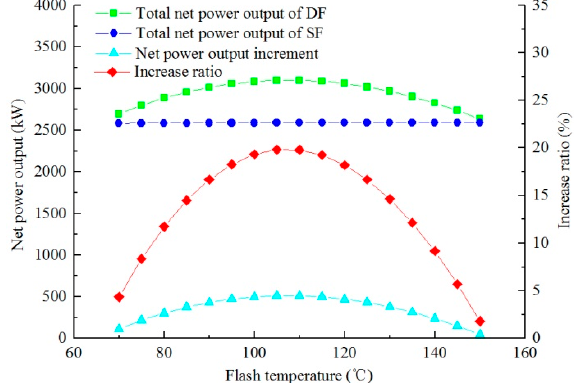
Figure 5. Variations of net power output of DF with flash temperature (geofluid temperature = 160 °C, steam dryness = 0.2, geofluid flow rate = 150 t/h).